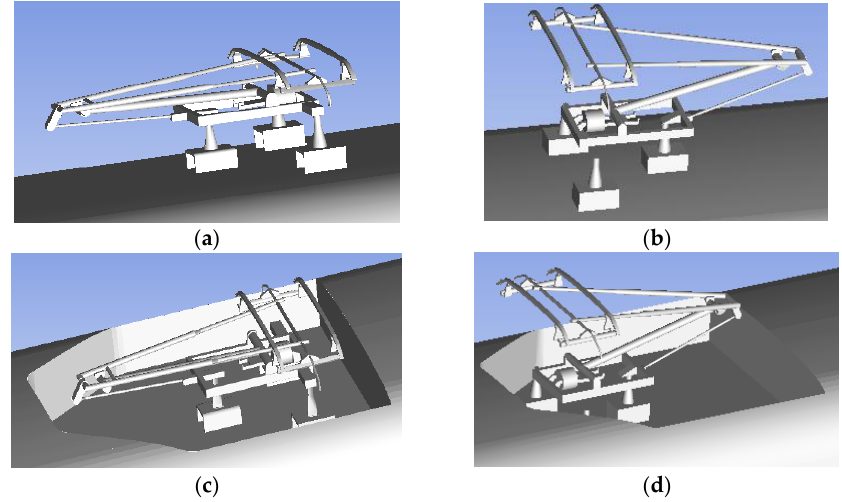
Figure 1. Model of pantograph.